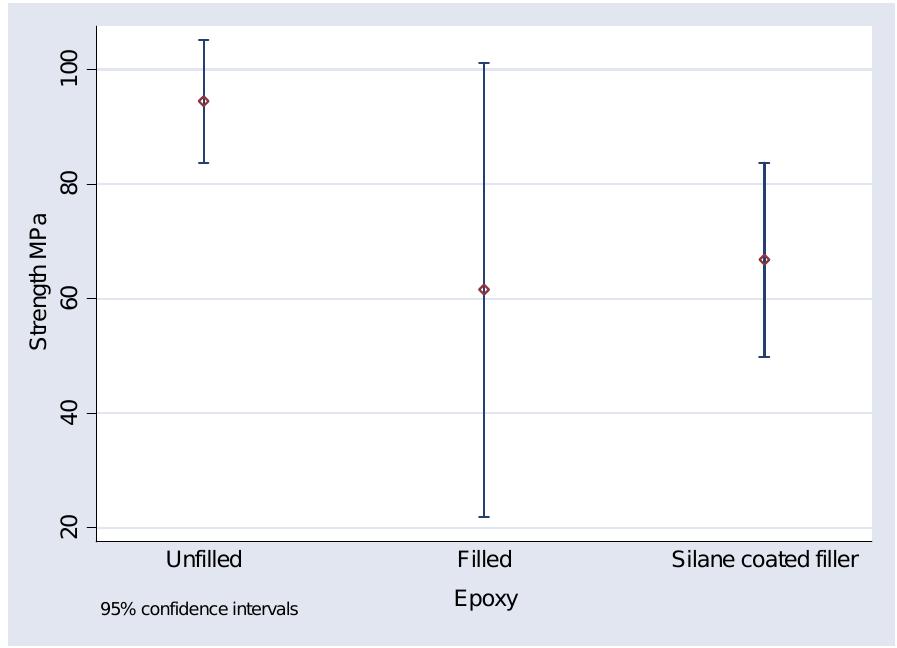
Figure 7. Means and 95% confidence intervals of the mean for epoxy resin in each of three states, unfilled, filled and with silane coated filler.